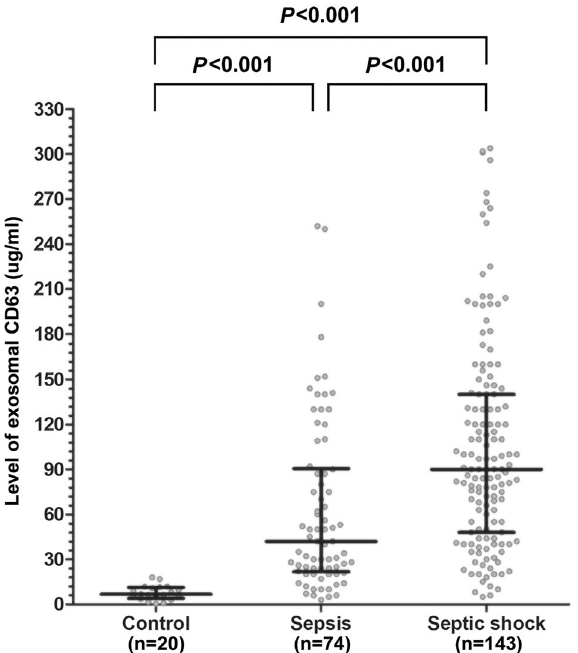
Figure 1. Exosomal CD63 levels in control, sepsis, and septic-shock groups. The line in the middle indicates the median and lines in the top and bottom indicate the interquartile ranges of exosomal CD63 levels.